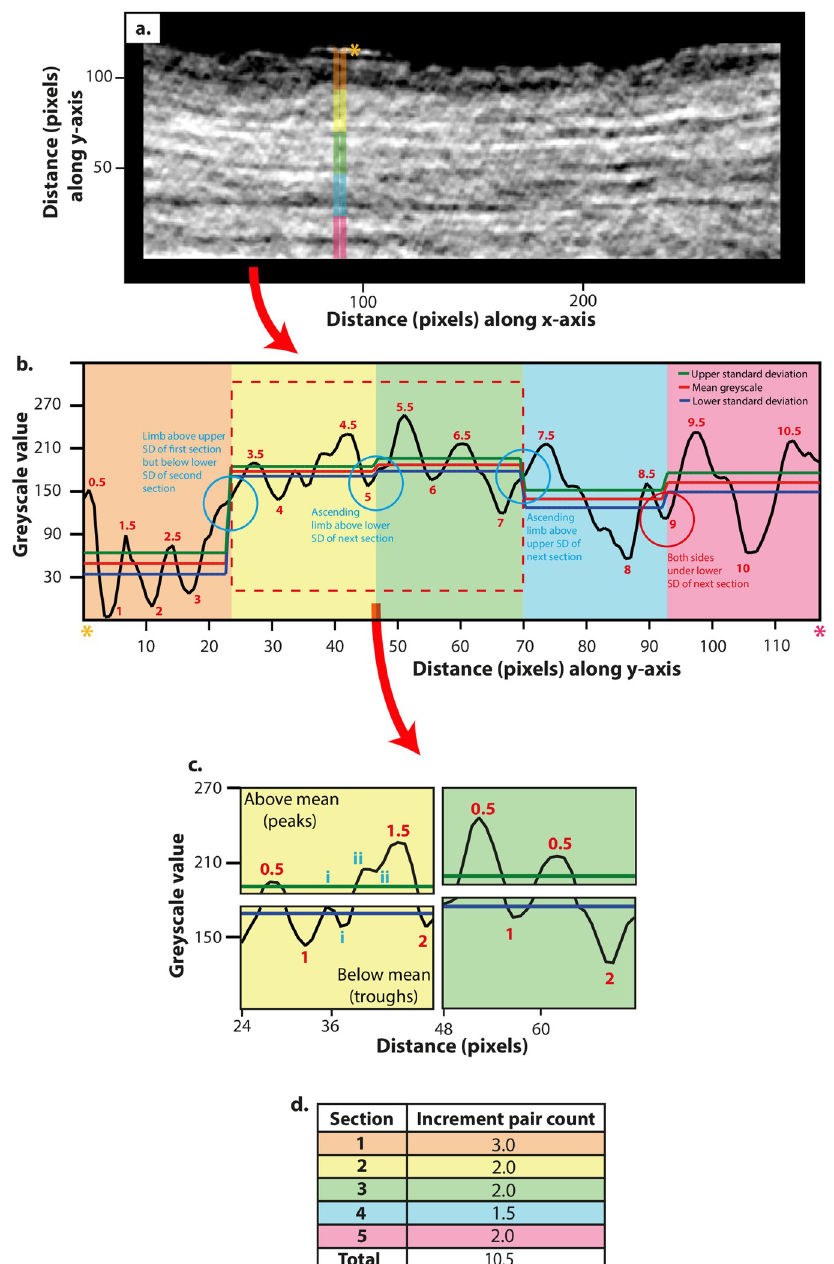
Fig 2. Tomographic cementum increment counting. ( a ) Straightened, filtered PPCI SR CT image of Macaca mulatta cementum (see Fig 5). ( b ) Plot of greyscale values along transect highlighted by the 10 pixel-thick coloured band in ( a ) with outer-cementum surface highlighted with orange asterisk and cemento-dentine boundary by red asterisk. Transects are split into five sections. Light/dark increment pairs are distinguished as peak/trough systems in greyscale values, where both the peak and trough depart from the mean greyscale value of that section (red line), beyond the half standard deviations of greyscale values within the section above the mean (green line) and below the mean (blue line), respectively. ( c ) Sections split into their upper and lower datasets comprising of peaks and troughs in greyscale that exceed beyond the upper and lower standard deviation (respectively). Here, peak/trough pairs are counted, denoted with red numbers. Troughs and peaks that are not counted are denoted in blue numerals, as they either do not exceed the standard deviation of that section or are less than three pixels away from the last respective peak/trough. ( d ) Resulting increment pair counts for each section as seen in ( b